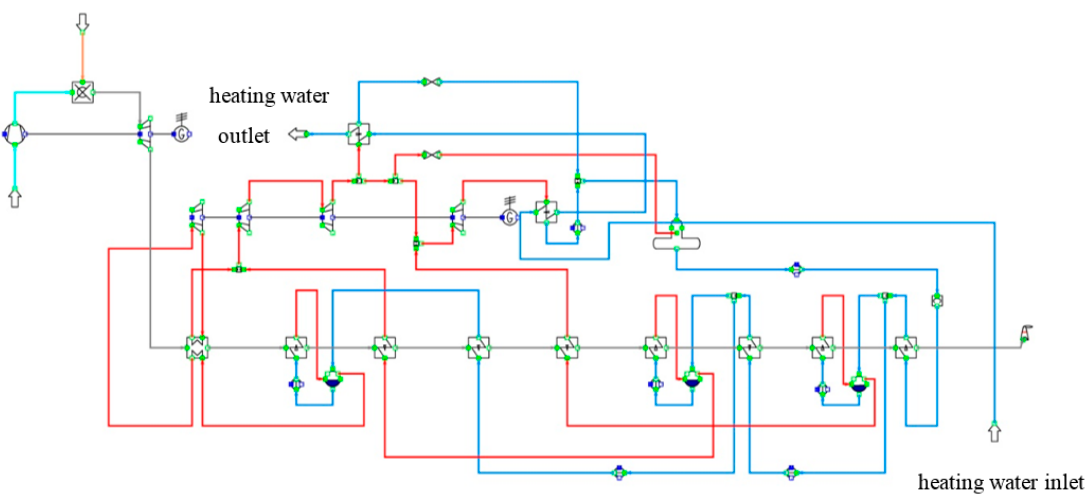
Figure 3. Schematic diagram of the gas and steam cycle.